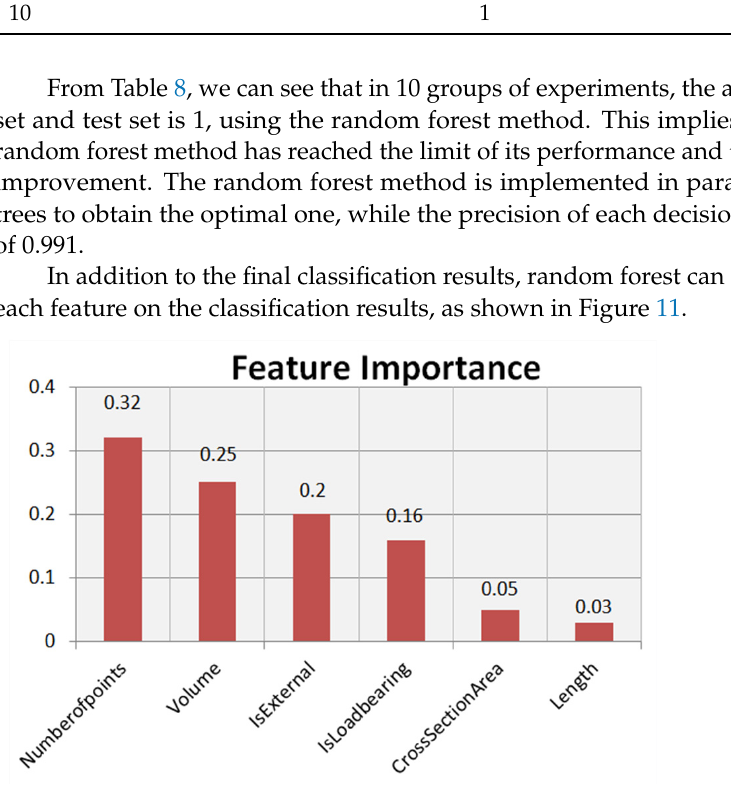
Figure 11. The influence of different characteristics on the classification results.